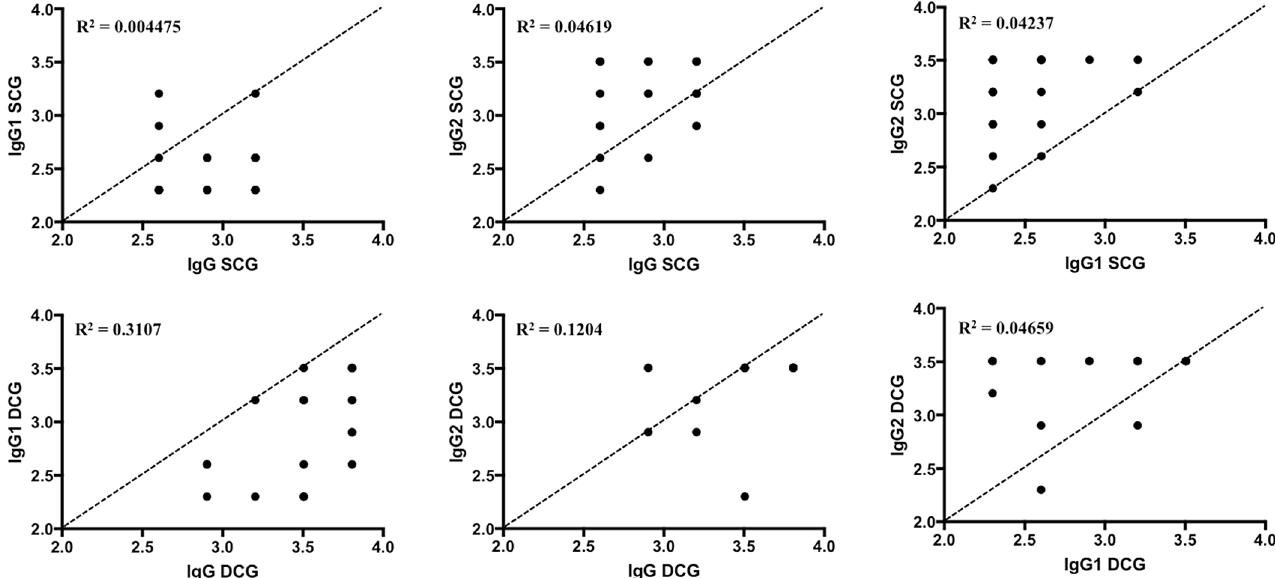
Figure 3. Correlation of log 10 transformations of sera titer values of IgG, IgG1, and IgG2 of the SCG (top) and DCG (bottom) groups obtained using ELISA. Diagonal dashed lines indicate what would be a perfect positive correlation ( r = 1) between the variables.